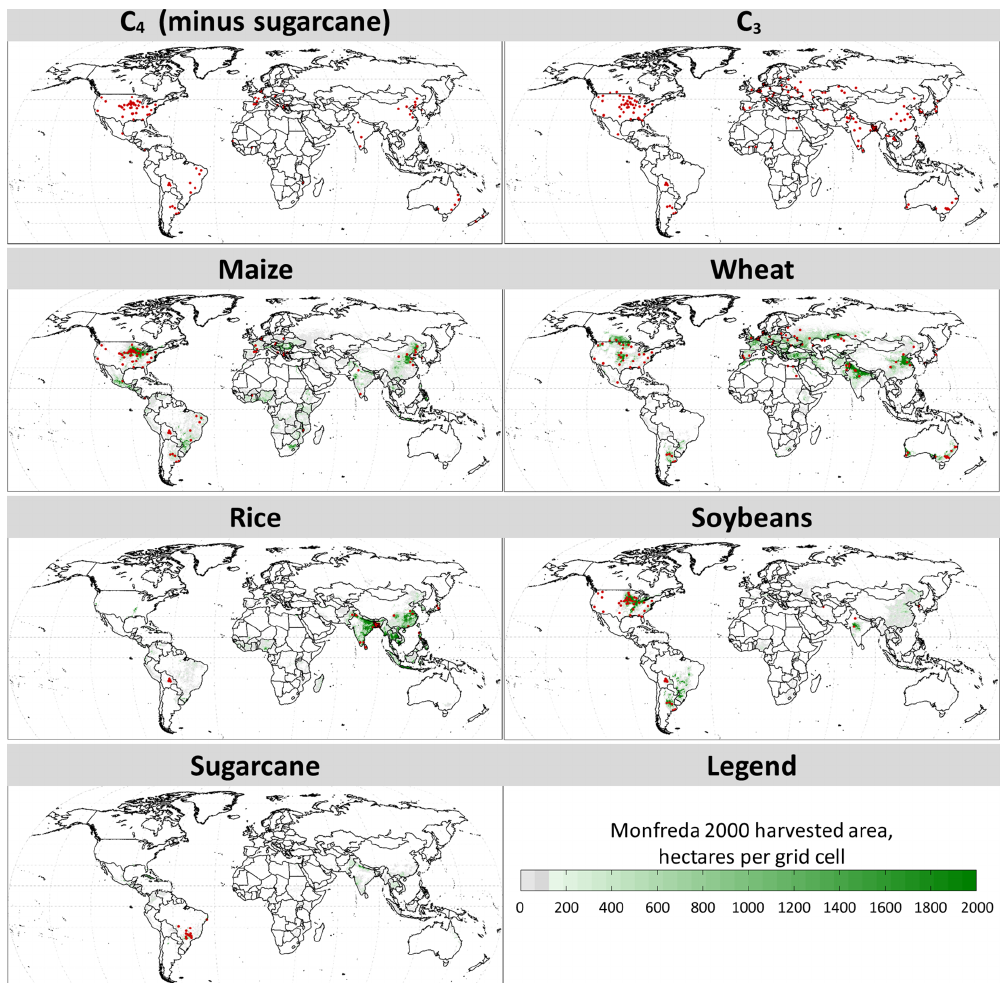
Figure 2. Maps of the C3MP data set culled sites. Each site represents a site-specific model of a single crop, with differing management practices. The sites are overlaid on Monfreda et al. (2008) harvested area data, except for the C 3 and C 4